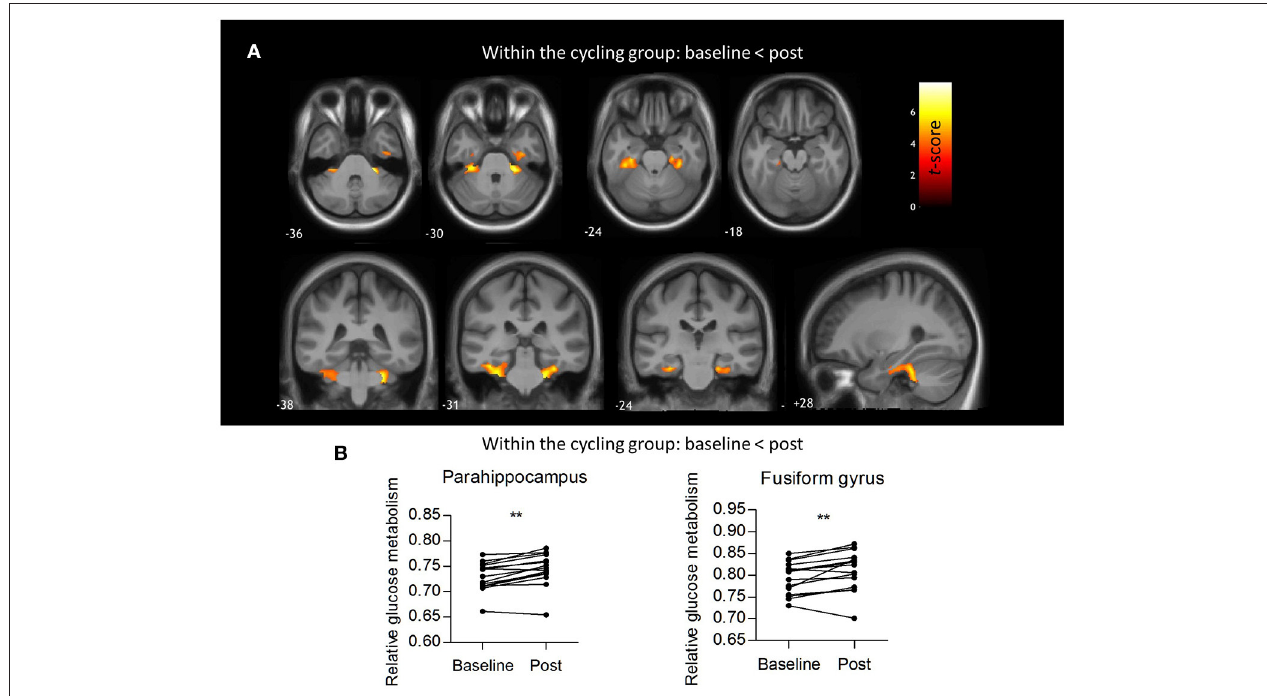
FIGURE 3 | Within-groups analysis of relative glucose metabolism. (A) Voxel-based paired t -statistical map for the cycling group showing increased relative glucose metabolism post intervention compared to baseline. Evaluation at P FWE < 0.05 corrected at cluster level, P height < 0.001 uncorrected at voxel level, K ext > 0.8 cm 3 . The results are projected on the group’s average 3D T1-weighted MR. (B) Regional relative glucose metabolism in the parahippocampus ( + 2.2%; P = 0.0002) and fusiform gyrus ( + 2.2%; P = 0.006), paired t -tests. **: P < 0.005.